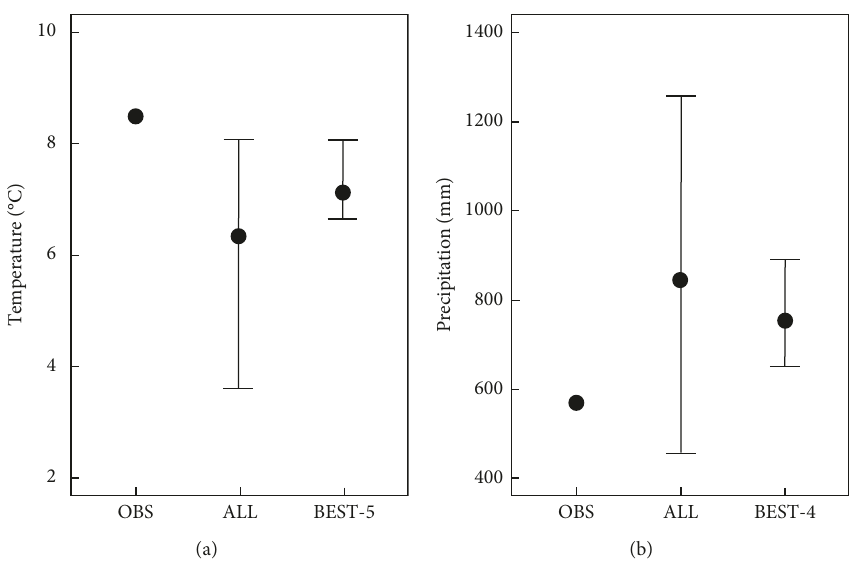
Figure 10: Comparison between the simulation results for all GCMs and those in the good GCM groups (the black solid circles represent the mean value of the group).